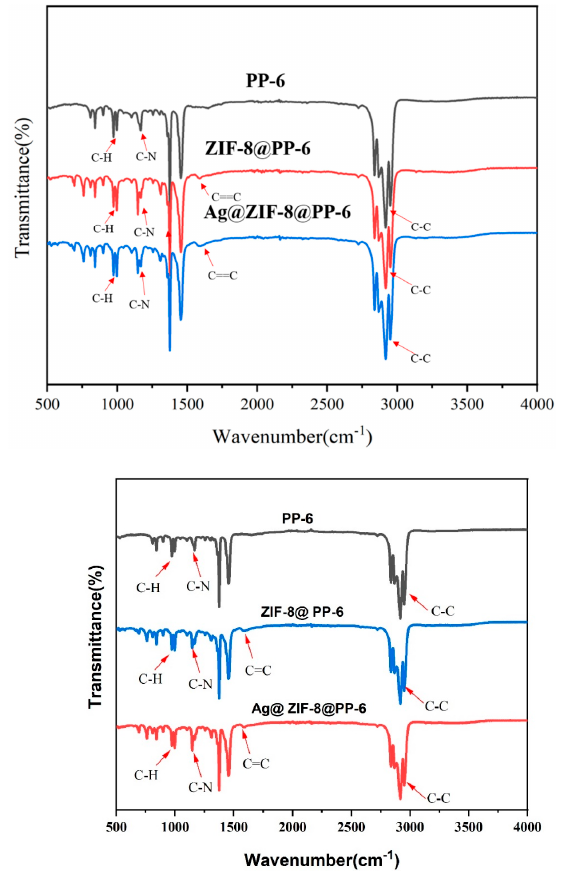
Figure 6. FTIR-ATR spectra of the grafted samples, including PP-6, ZIF-8@PP-6, and Ag@ZIF-8@PP-6.